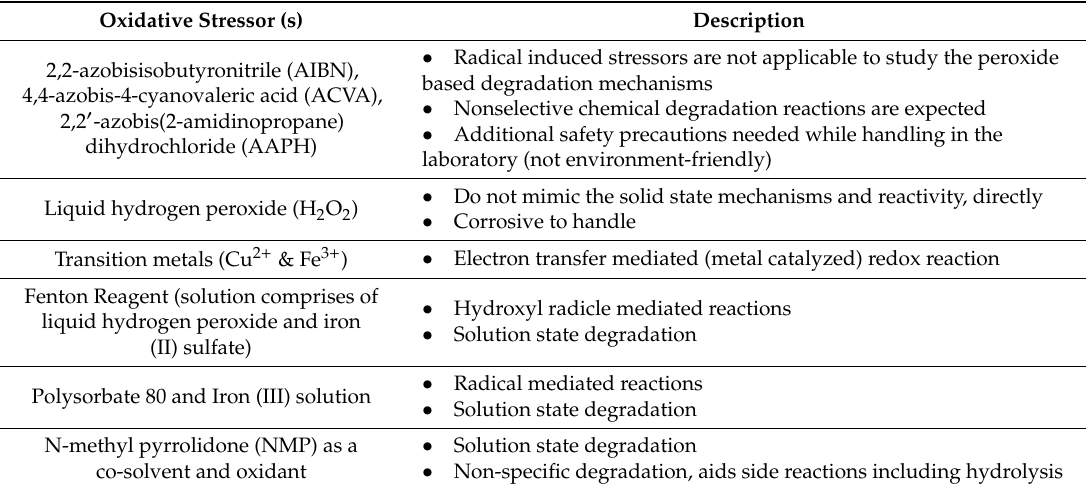
Table 1. Commonly used oxidative stressors, their scope and